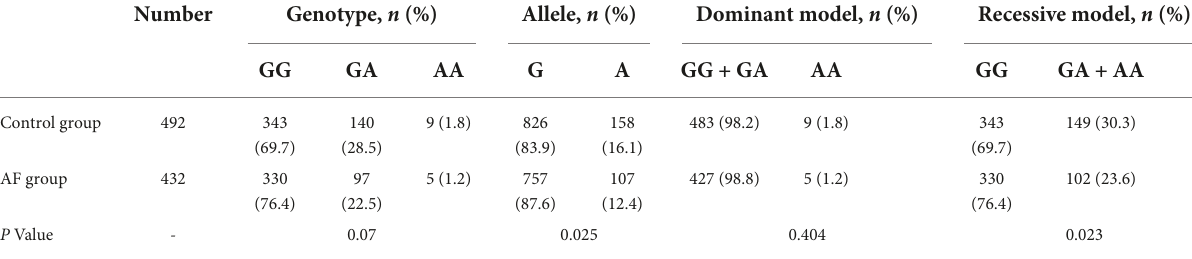
TABLE 2 The distribution of genotype and allele frequency between the control and AF group.